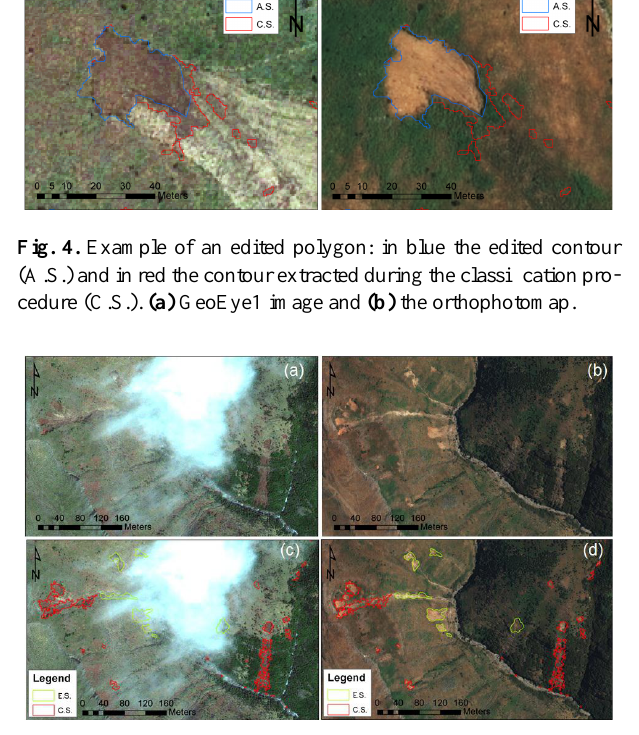
Figure 5 – Example of added polygons: in red the contours extracted during the classification procedure (C.S.) and in green the contours added because of clouds and shadows (L.S.). On the left GeoEye imagery, and on the right orthophotomaps used for correct the classification.